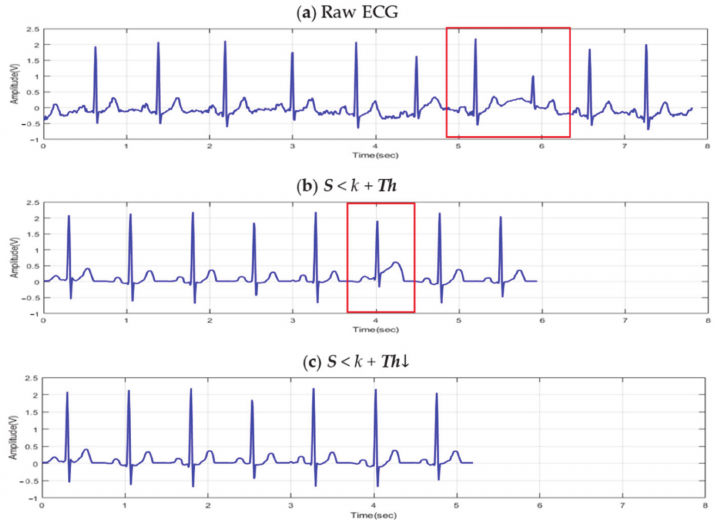
Figure 8. ECG cycle filtered as PSR decrease: ( a ) raw ECG ( b ) S < k + Th ( c ) S < k + Th ↓ .